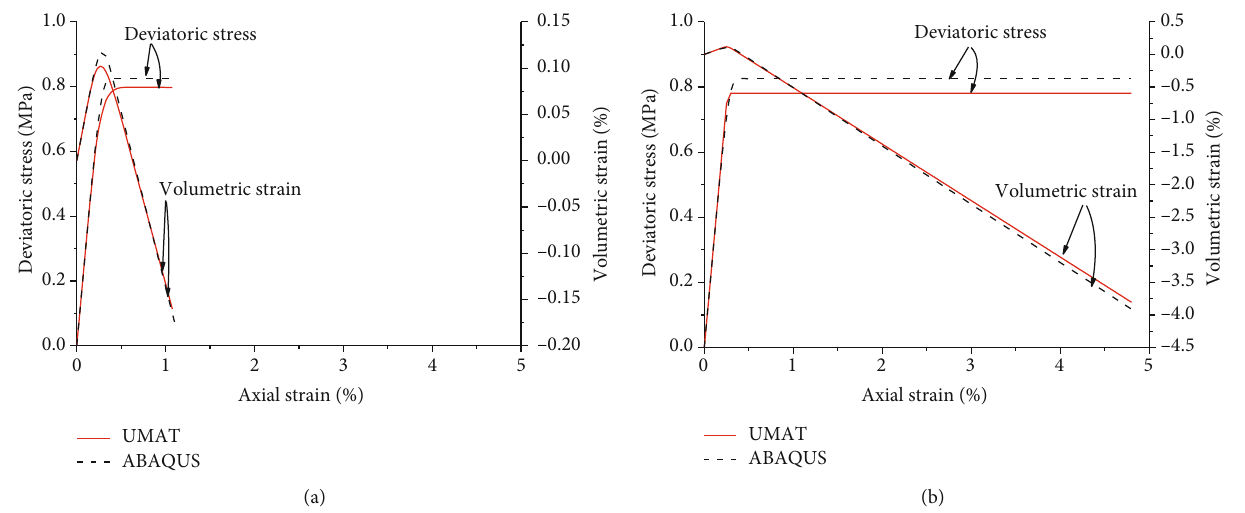
Figure 7: Stress-strain relationship under uniaxial compression: (a) nonassociated fl ow and (b) associated fl